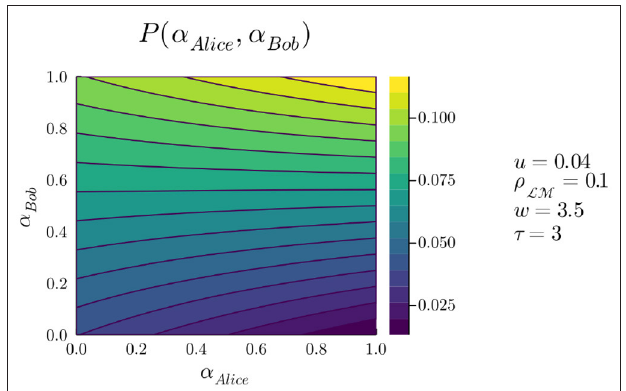
FIGURE 6 | P ( α Alice , α Bob ) for u = 0.04, ρ LM = 0.1, w = 3.5, and τ = 3.